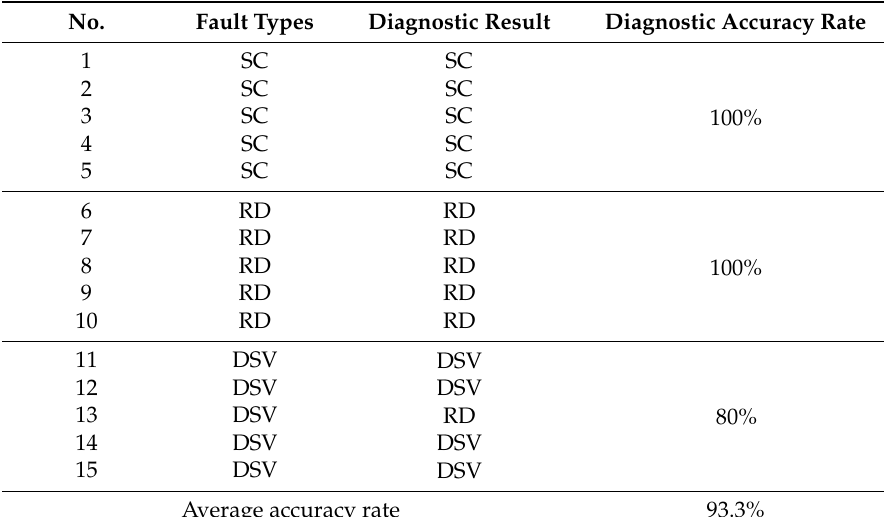
Table 6. Result of classifying a typical testing set using SVM